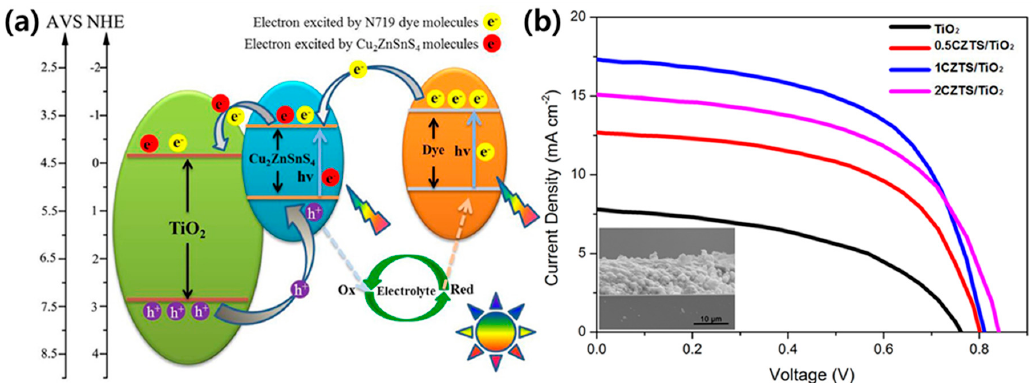
Figure 4. ( a ) Energy band structure and photogenerated charge transfer mechanism in Cu 2 ZnSnS 4 (CZTS) nanoparticles / MOF-derived TiO 2 . ( b ) Current density–voltage curves of MOF-derived TiO 2 and CZTS / TiO 2 samples. Reprinted from [72] with permission. Copyright © 2016, American Chemical